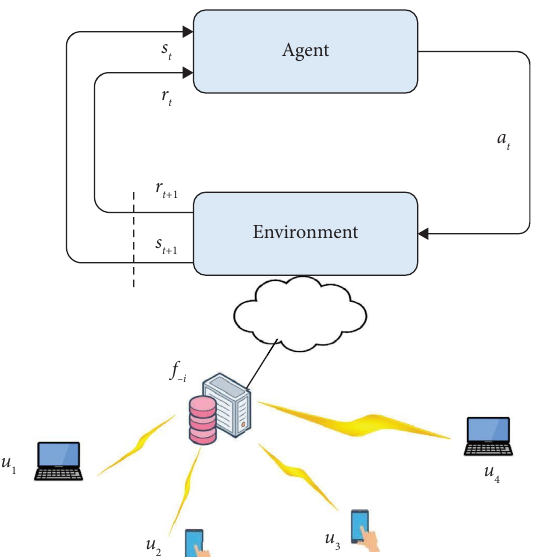
Figure 3: Elements of Q-learning: environment, action, state, and reward.